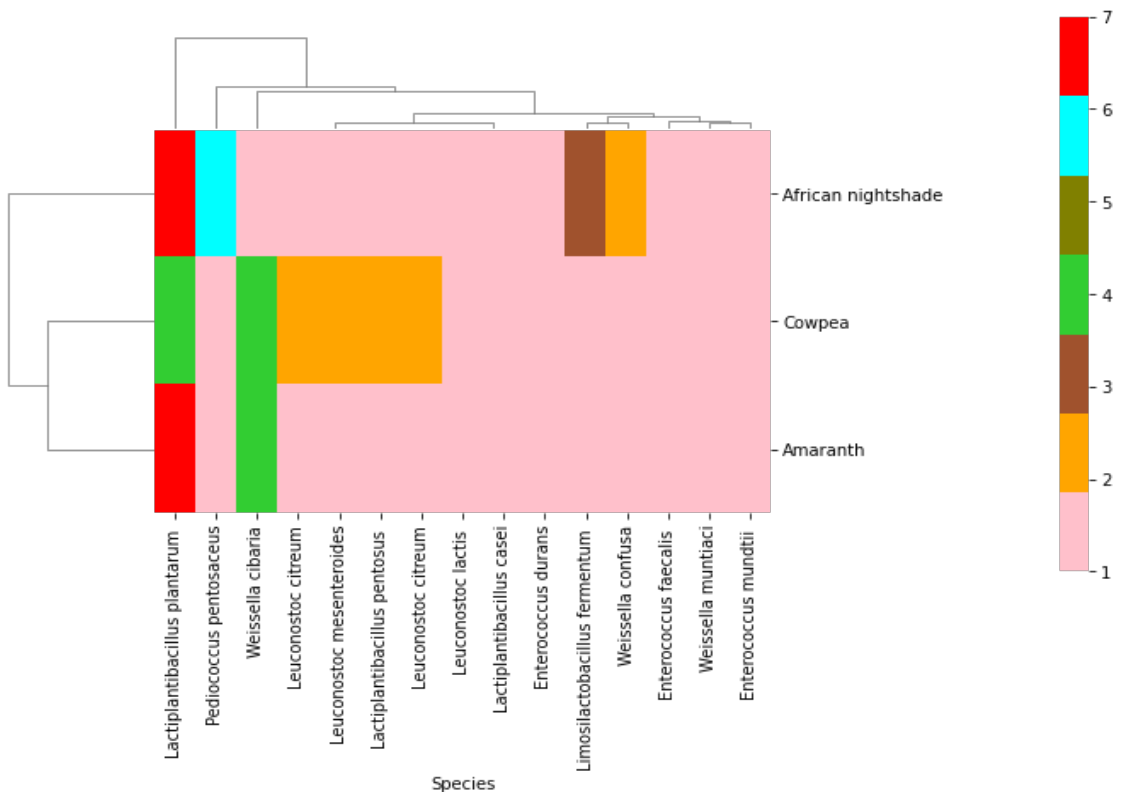
Figure 3. Hierarchical clustering of lactic acid bacteria from three fermented African indigenous leafy vegetables at the species level. Legend: Hierarchical clustergram generated using several bacteria species at different types of African indigenous leaf vegetables. The heatmap (Euclidean matric) shows the relationship between selected bacteria species and varied African vegetables. The colored scale bar indicates the significant quantified strength of the various African vegetables. The red color in the heatmap indicates the highest, and pink indicates the lowest significance at p ≤ 0.05 for the assayed